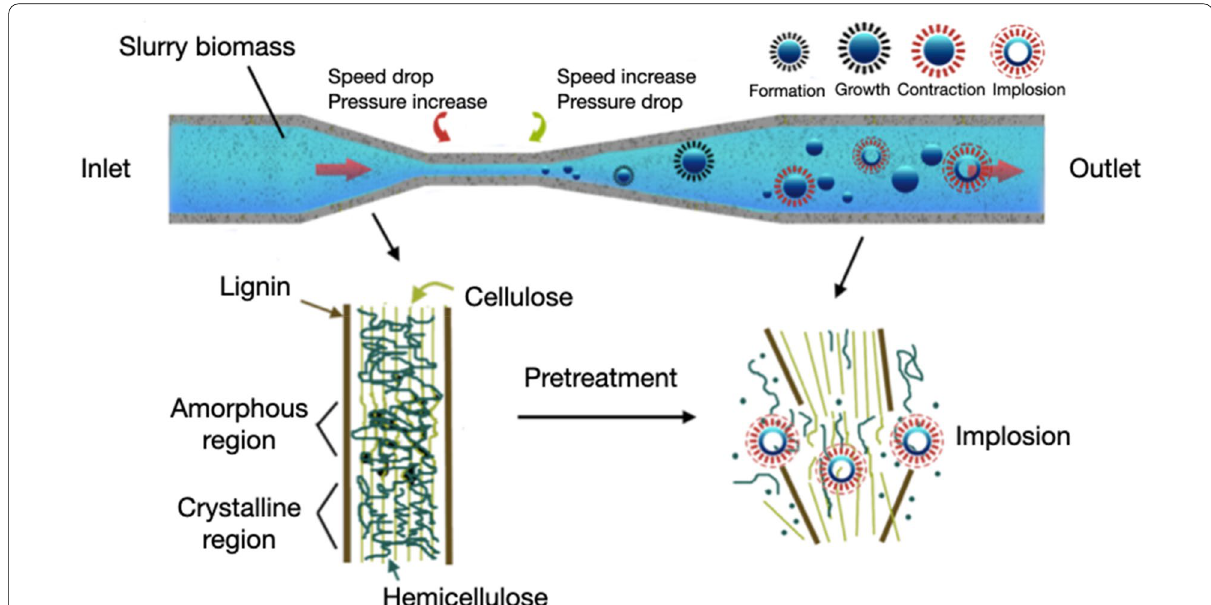
Fig. 2 Mechanical effect of hydrodynamic cavitation on lignocellulosic biomass